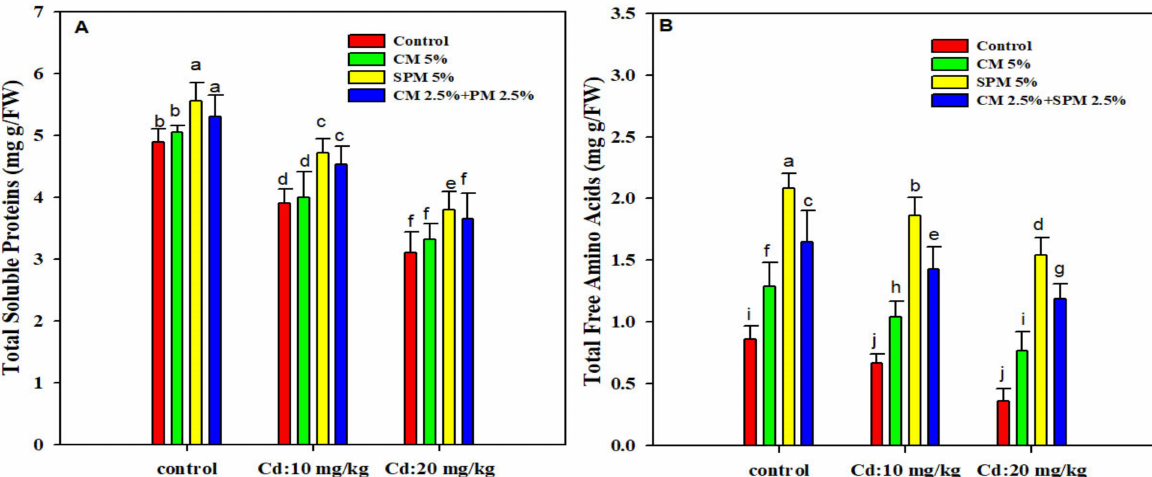
Figure 5. Effect of organic amendments on total soluble protein ( A ) and free amino acid contents ( B ) activities of mash bean plants subjected to different levels of Cd stress (0, 10 and 20 mg/kg). The vertical bars in each figure are the mean of three replications with ± S.E. and different letters on bars indicating the significant difference at p <